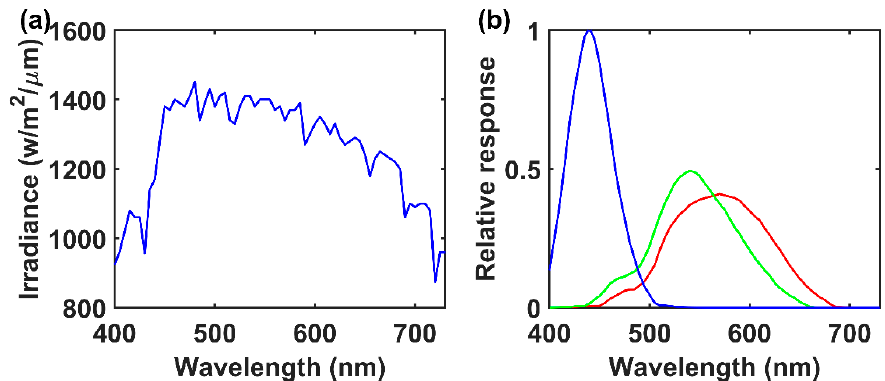
Figure 2. ( a ) Terrestrial direct solar spectrum. ( b ) Spectral response curves of human photoreceptors (i.e., spectral absorption of light by the three cone types).